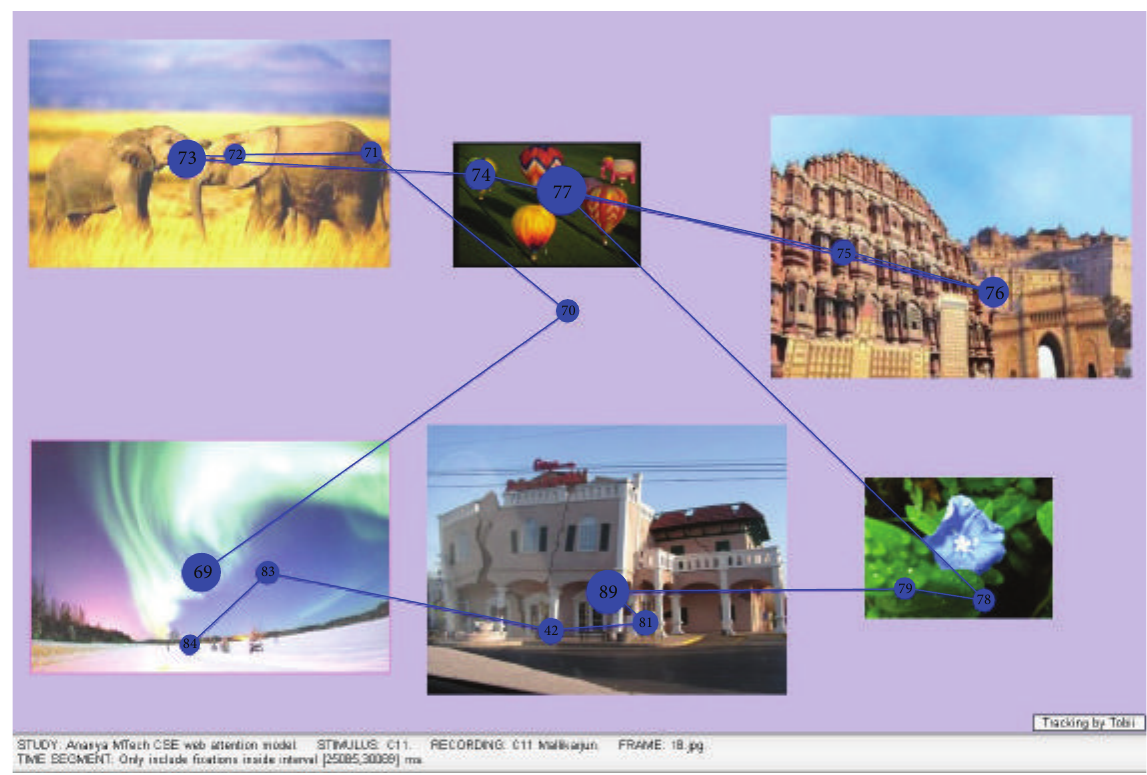
Figure 11: An example gaze plot of a participant for the page shown in Figure 10. The blue circles show the point of gaze. The larger the circle, the larger the gaze duration at the point.